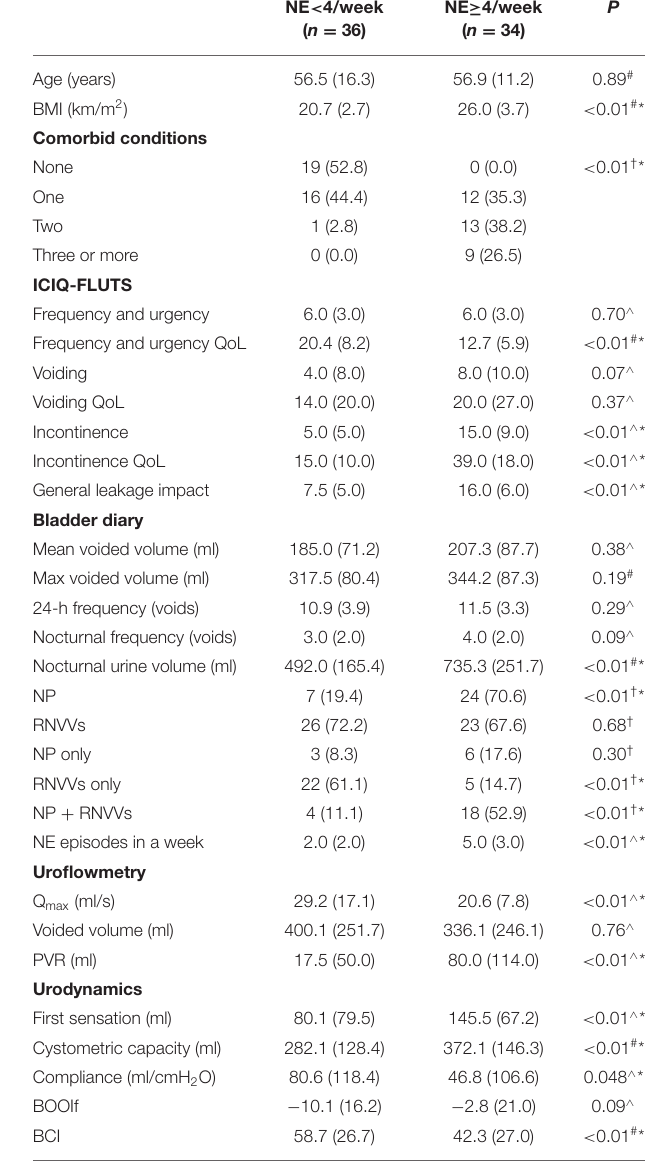
TABLE 3 | Subgroup analysis stratified by enuresis